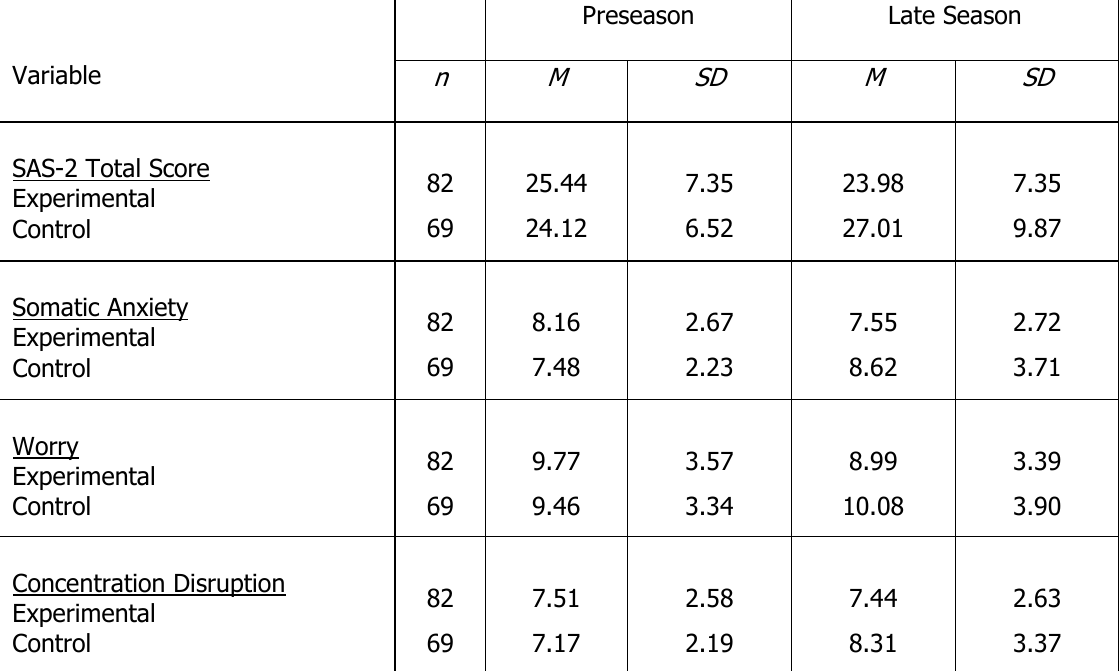
Means and Standard Deviations of Preseason and Late Season SAS-2 Total and Subscale Scores for Intervention and Control Conditions